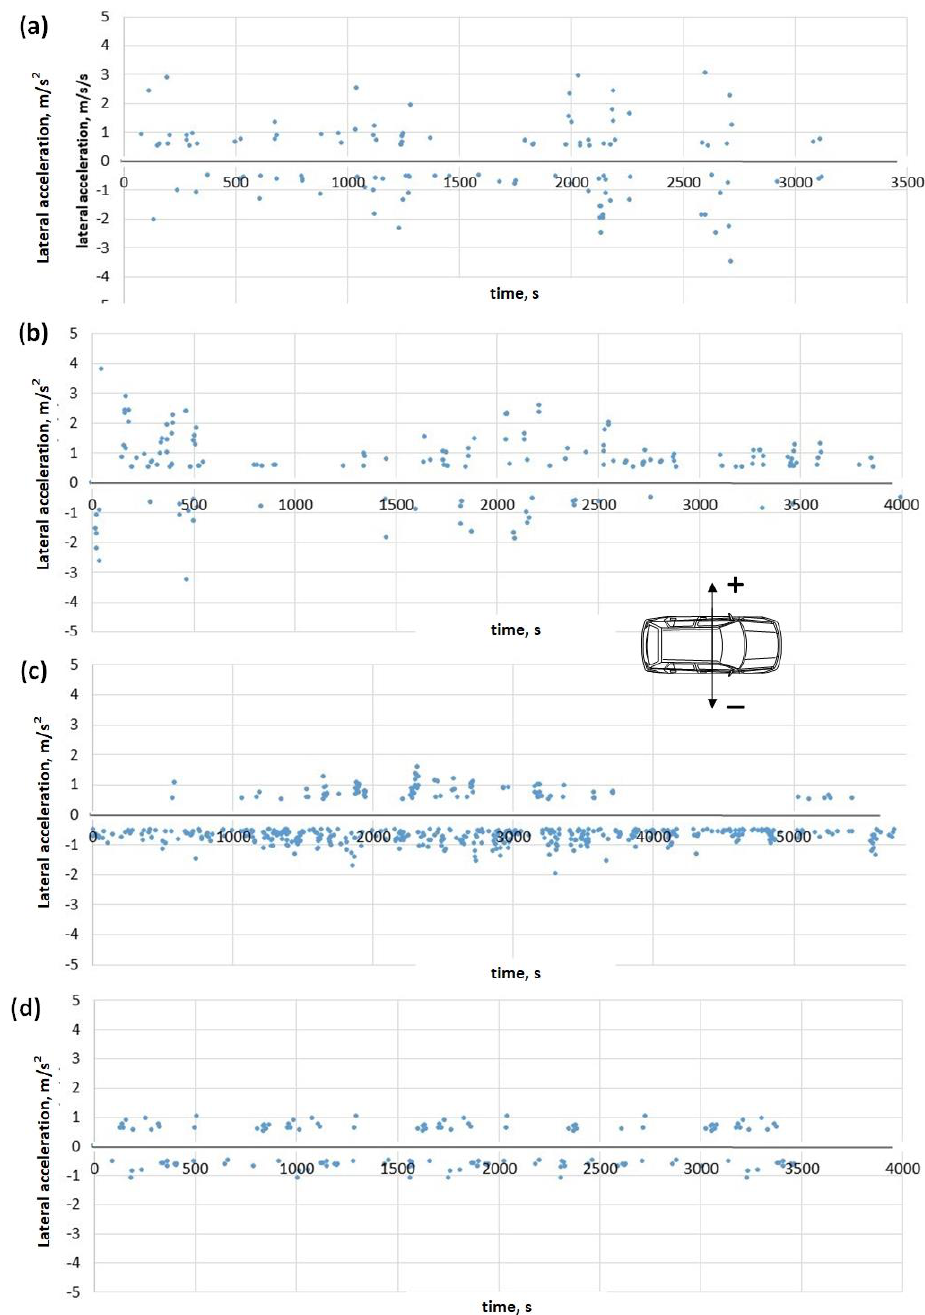
Figure 7. Lateral acceleration extreme values in the right and left turning maneuvers on the different sections of the route: ( a ) city road; ( b ) suburban road; ( c ) expressway (dual carriageway); ( d ) high- way.